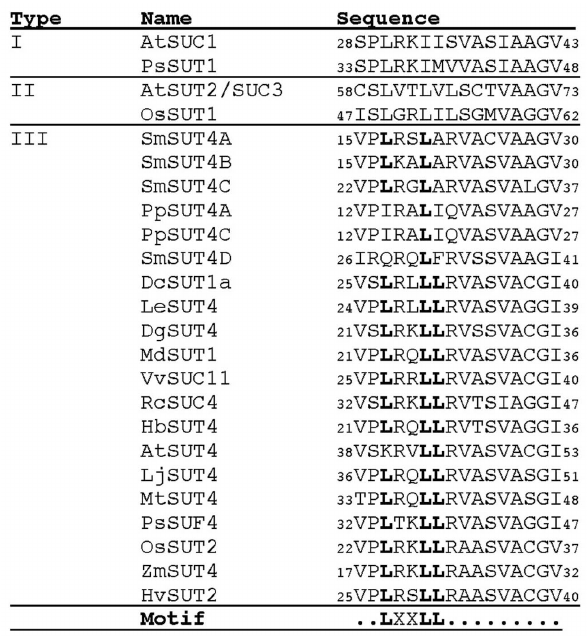
FIGURE 4 | Putative dileucine-like vacuolar targeting sequence in type III SUTs. A part of the multiple protein alignment of sucrose transporters is shown. All type III SUTs and selected type I and II SUTs are shown for comparison. Numbers indicate the amino acid positions for each protein. Amino acid positions that conform to the dileucine-like motif LXXLL are shown in